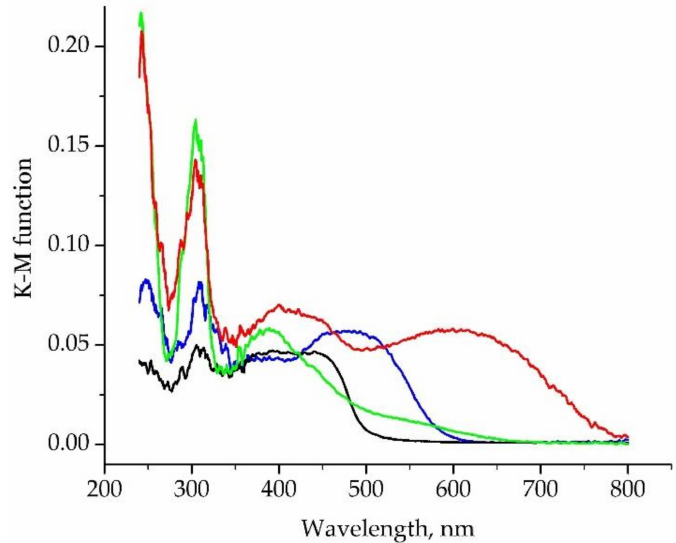
Figure 12. Absorption spectra of the solid samples of H 2 L (black), 1 · nC 7 H 8 (red), 2 · nC 7 H 8 (blue) and 3 nTHF (green) mixed with BaSO 4 , presented in the form of Kubelka-Munk (K-M)